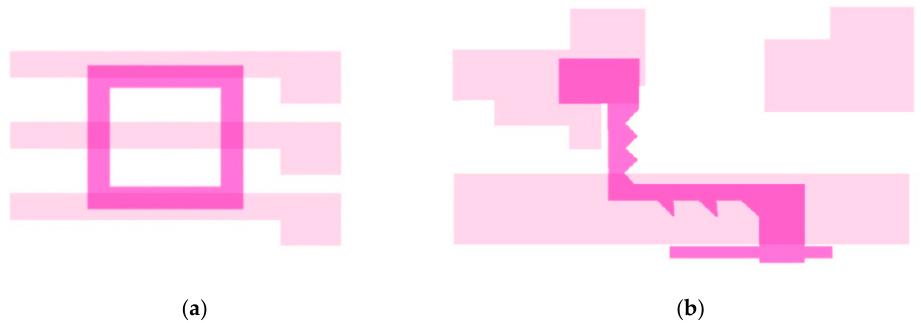
Figure 13. Conceptual reference plans of HPS IV ( a ) and the FS ( b ) Drawings: Carlos Pastor García.